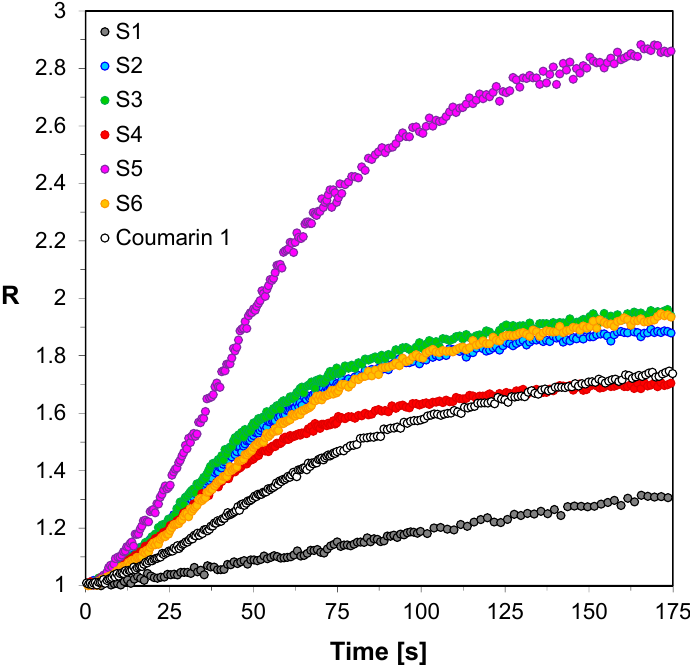
Figure 4. Monitoring thiol-ene photopolymerization of TMPTMA/MERCAPTO (50%/50% w / w ) monomer under 320 nm by FPT, using the 2-amino-4,6-diphenyl-pyridine-3-carbonitrile derivatives (S1-6) as the fluorescent sensors and Coumarin 1 (C1) as a reference probe.